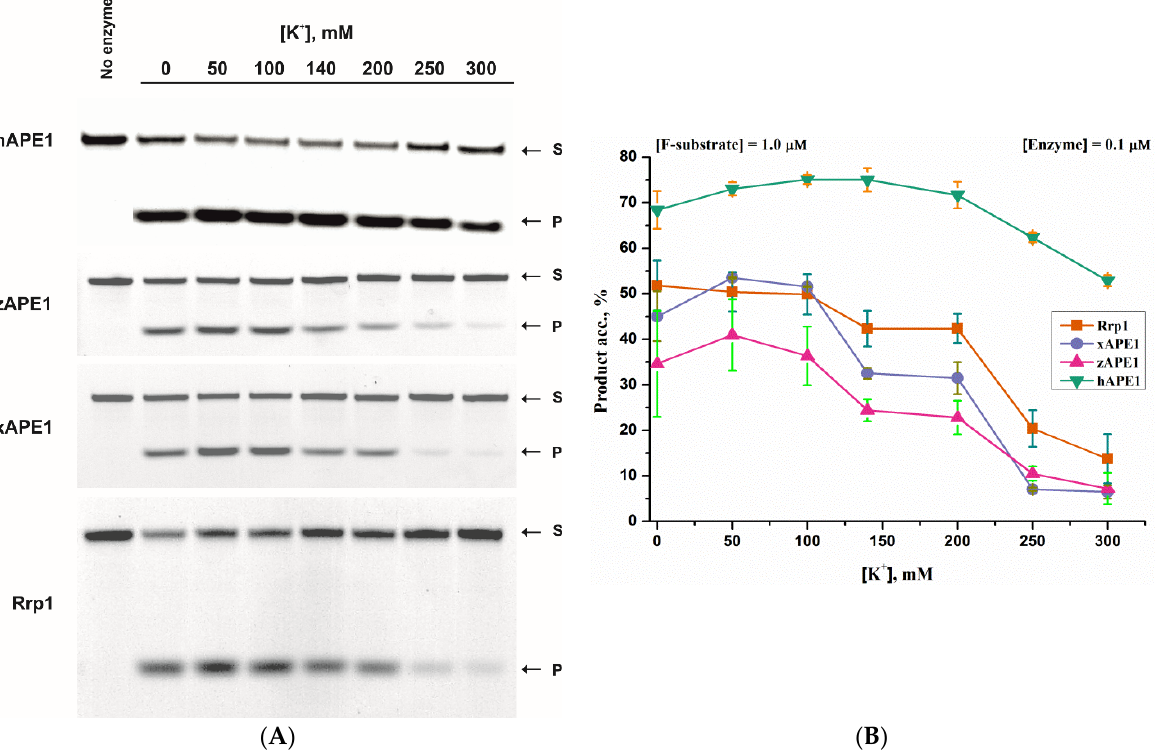
Figure 2. The influence of monovalent cations (K + ) on the AP-endonuclease activity of the enzymes under study. Accumulation of a reaction product P from F-substrate S as determined by PAGE ( A ). Dependences of the cleavage efficacy on K + concentration ( B ). The error was calculated by averaging each data point over at least three replicates.